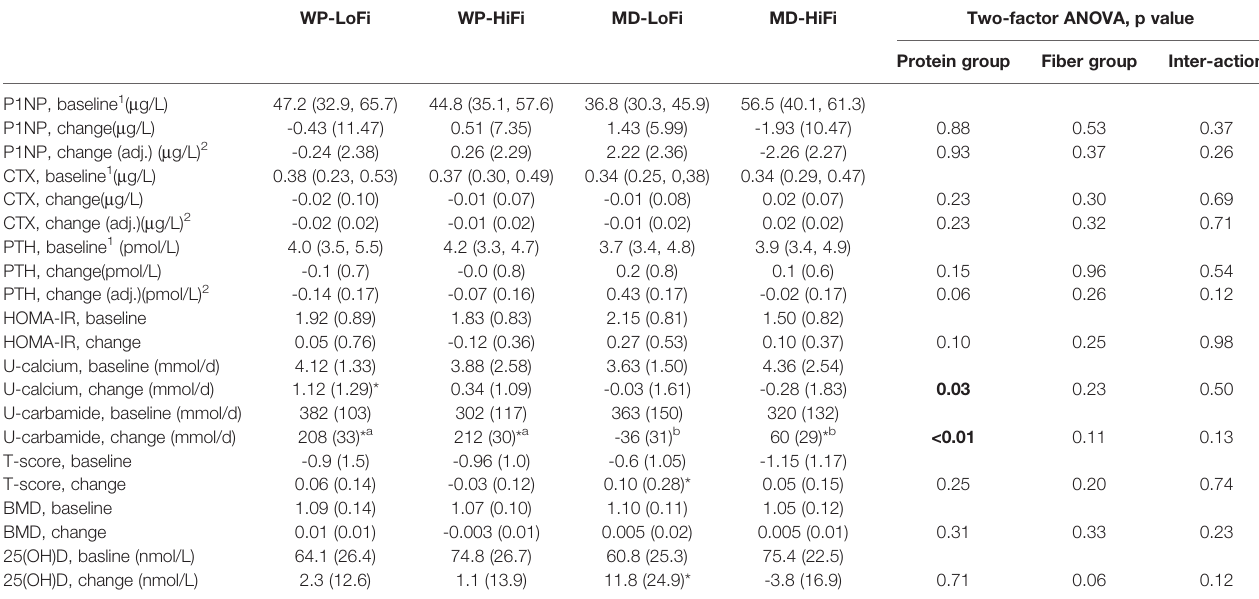
TABLE 2 | Baseline values and changes following 12-weeks of dietary intervention.